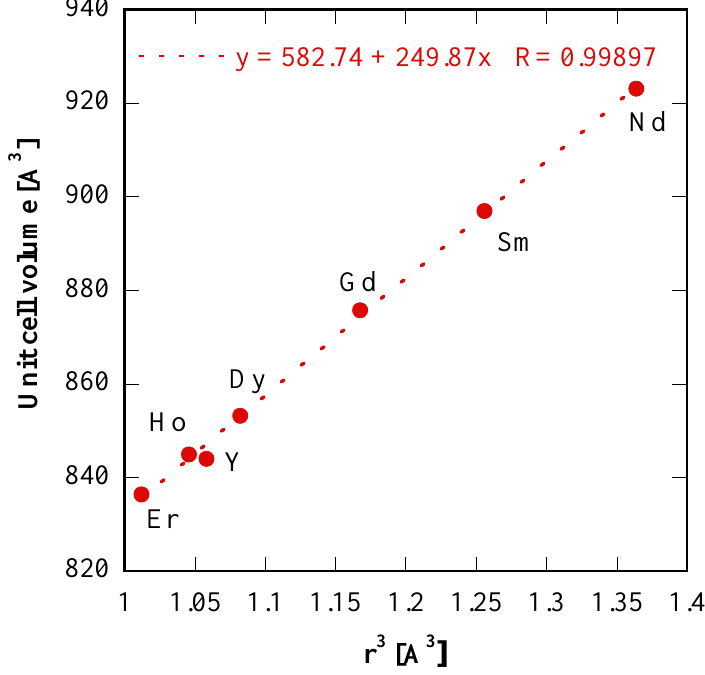
Figure 4. Unit cell volumes of “tengerite-(RE)” rare-earth carbonates as a function of ionic radius raised to cubic power.